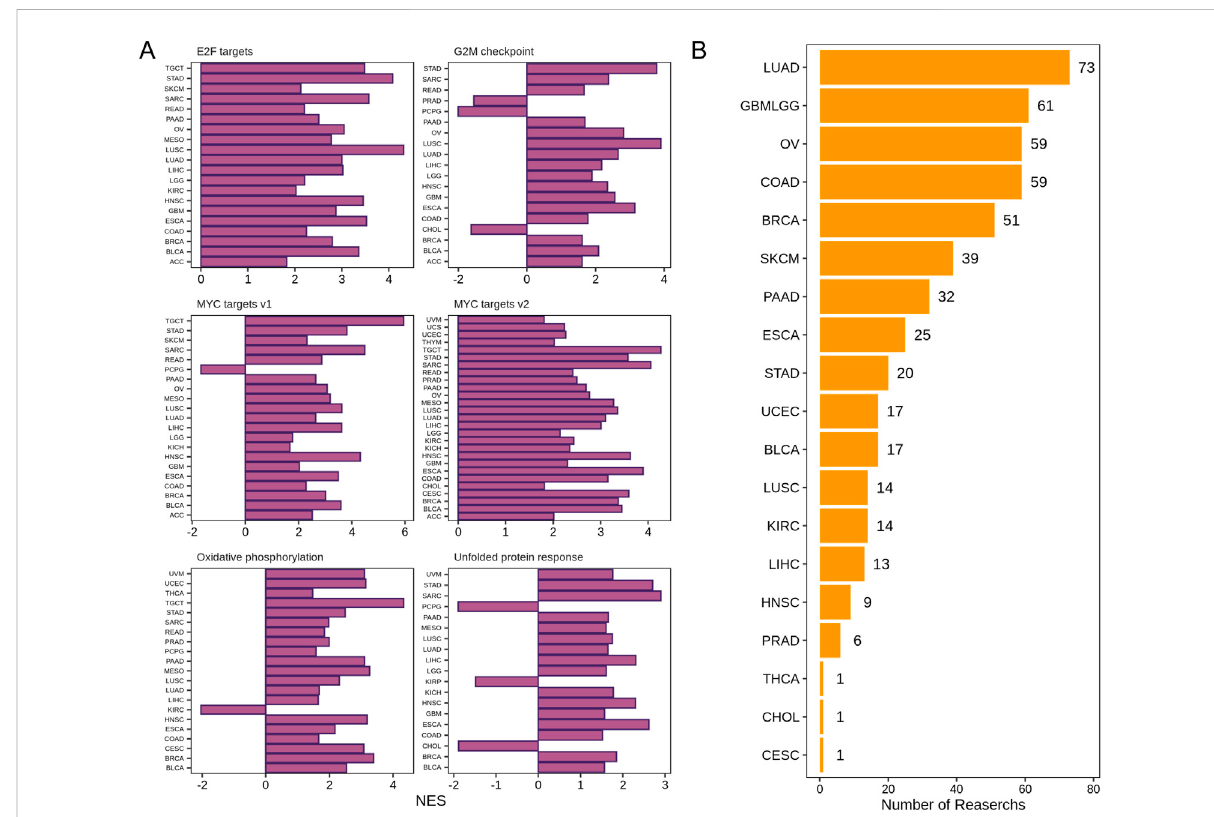
DDX56 positively modulates the proliferation of cancer cells. (A) GSEA enrichment results for DDX56 in multiple tumor types. Only pathways deemed to be signi fi cantly enriched based on GSEA ( p < 0.05) are illustrated. (B) Multiple CRISPR screening studies verifying that DDX56 can positively regulate the proliferation of cancer cells. X -axis indicates the number of CRISPR screening studies supporting a pro-proliferative phenotypic role of this gene in tumor cell lines. Y -axis indicates the tumor type of the CRISPR screens studies. Abbreviations: ACC: adrenocortical carcinoma; BRCA: breast invasive carcinoma; COAD: colon adenocarcinoma; GBM: glioblastoma multiforme;HNSC: head and neck squamous cell carcinoma; KICH: kidney chromophobe; KIRC: kidney renal clear cell carcinoma; LIHC: liver hepatocellular carcinoma; LUAD: lung adenocarcinoma; LUSC: lung squamous cell carcinoma; MESO: mesothelioma; OV: ovarian serous cystadenocarcinoma; PAAD: pancreatic adenocarcinoma; PCPG: pheochromocytoma and paraganglioma; PRAD: prostate adenocarcinoma; READ: rectum adenocarcinoma;